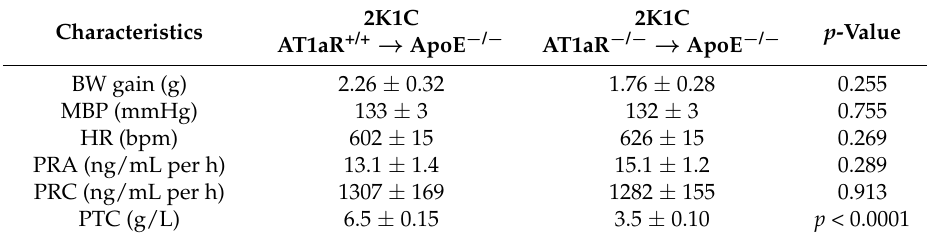
Table 1. Physiological parameters in 2K1C ApoE − / − mice transplanted with AT1aR +/+ or AT1aR − / − BM. Data are expressed as mean ±